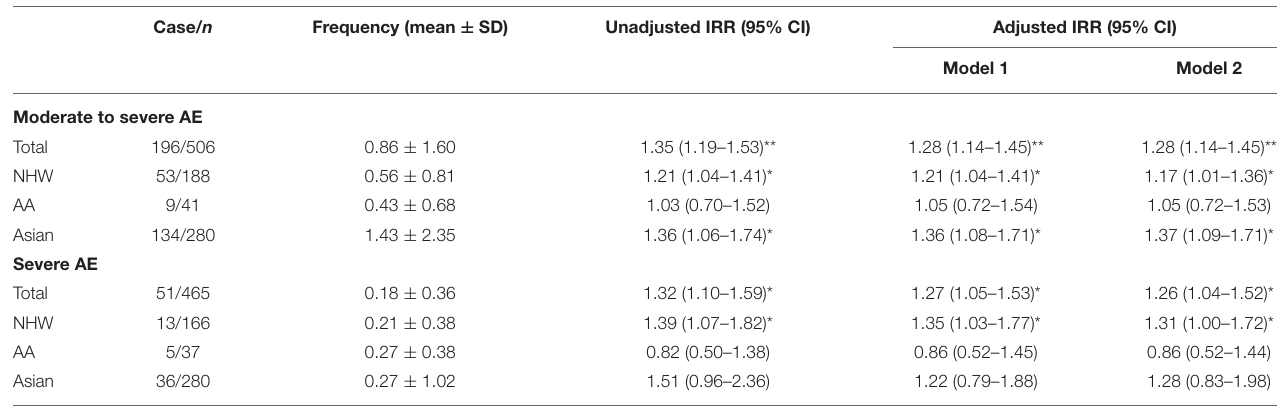
TABLE 3 | Risk for exacerbation during 1-year follow-up in patients with ACO according to race and ethnicity. Case/